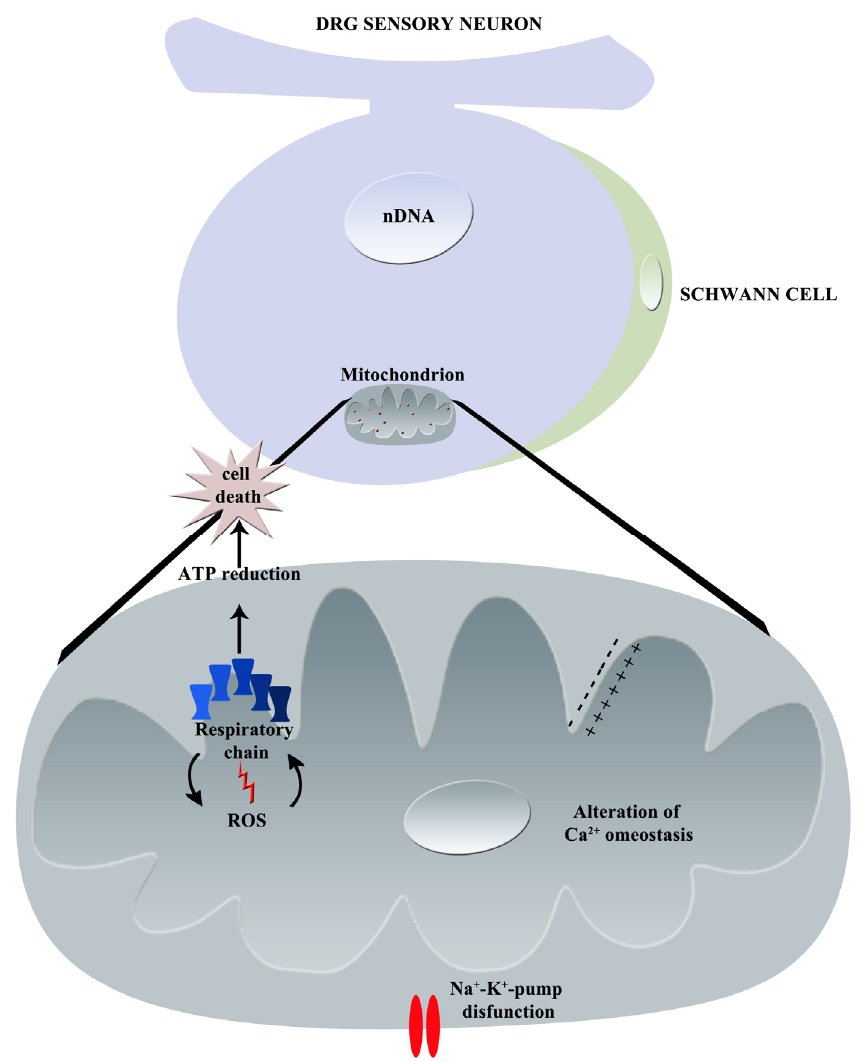
Figure 5. Graphical summary of bortezomib-induced mechanisms of neurotoxicity: principal effects on mitochondrion (nDNA = nuclear DNA, ROS = Reactive Oxygen Species, Ca 2+ = calcium, Na + = sodium, K + =